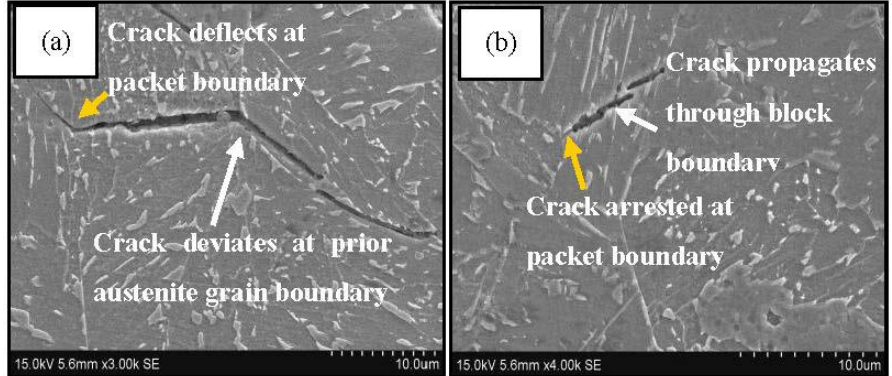
Figure 10. The secondary cracks underneath the fracture surface of impact samples: ( a ) cracks deviate at the prior austenite grain boundary and the bainite packet boundary; ( b ) cracks propagate through the bainite block boundary and are arrested at the packet boundary.